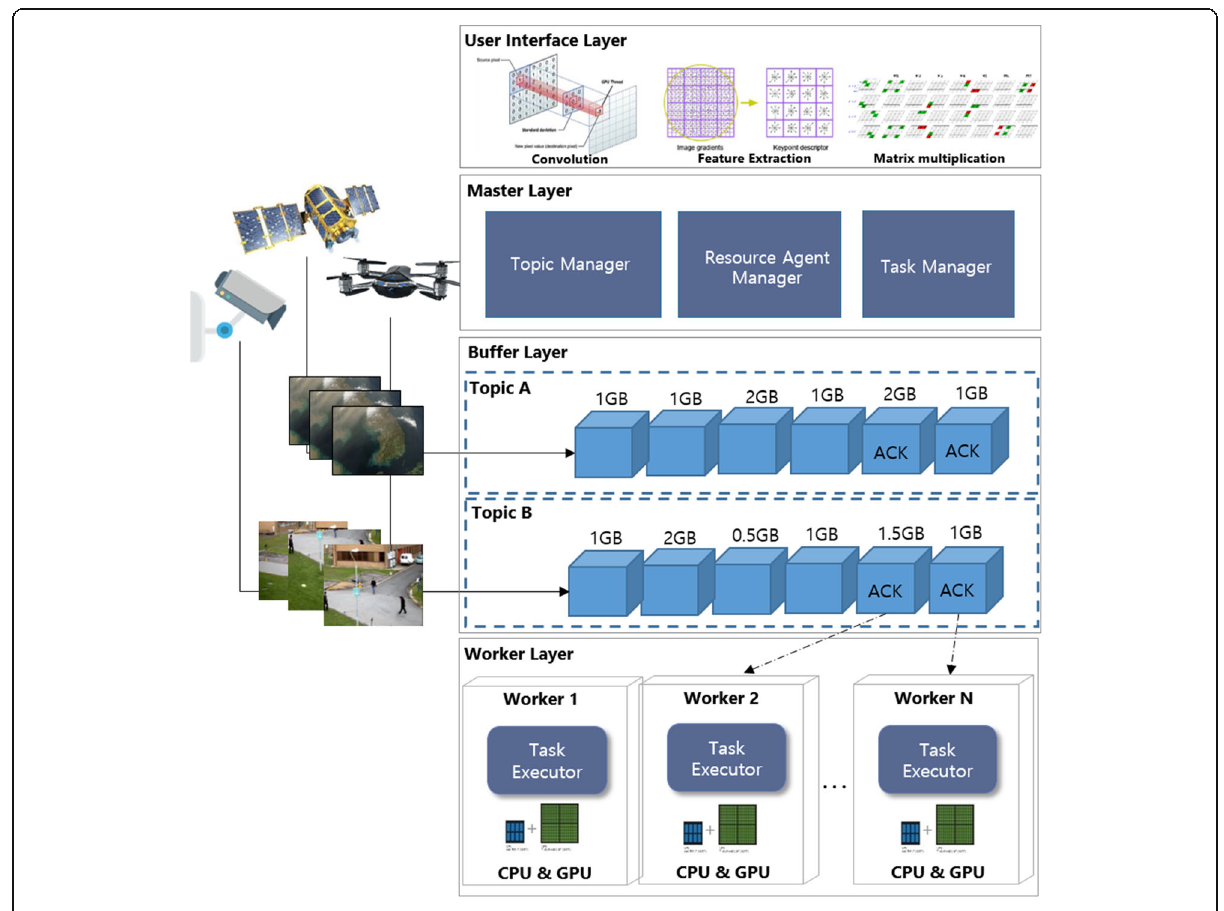
Fig. 1 System overview of RIDE